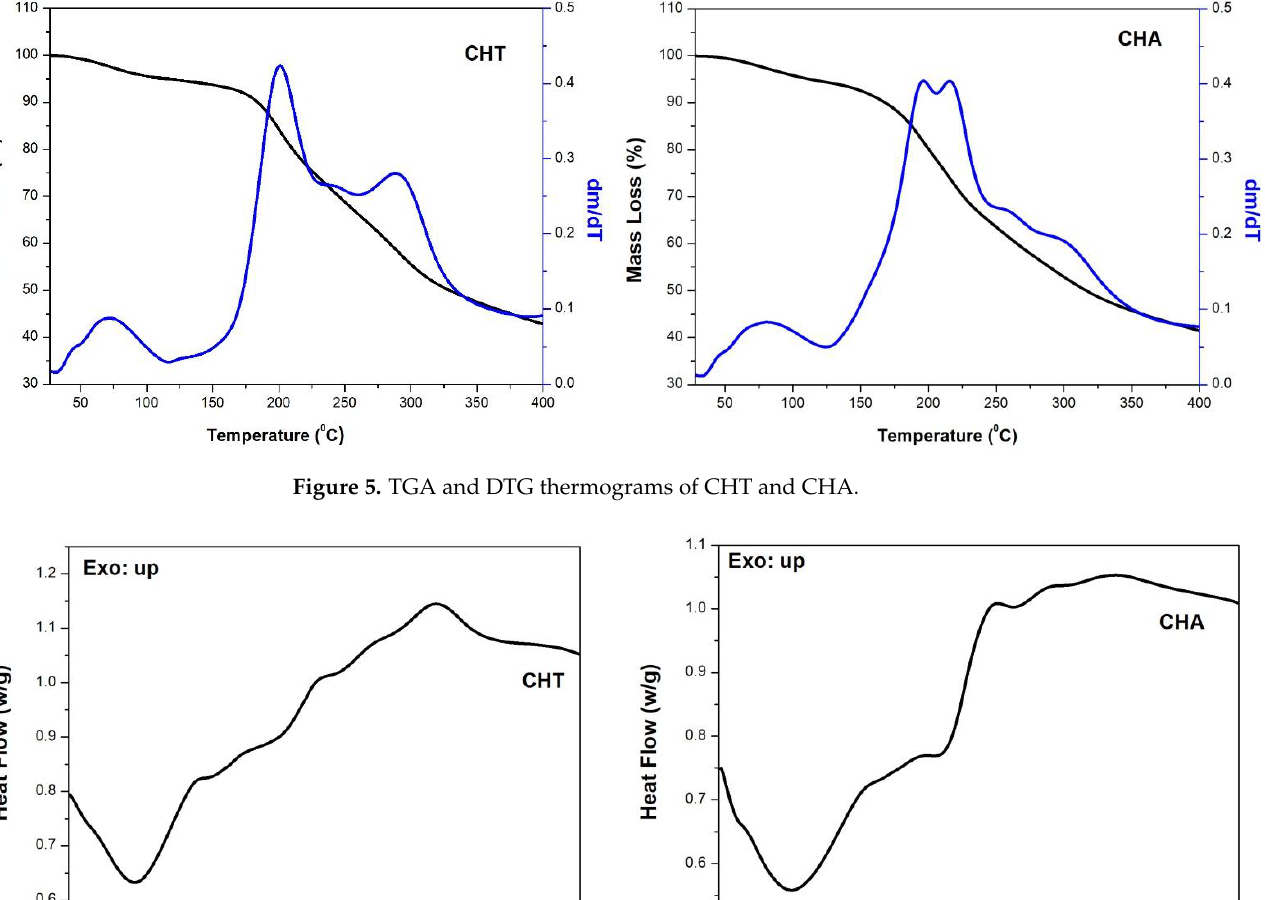
Table 3. 2 θ angle and d-spacing of chañar films